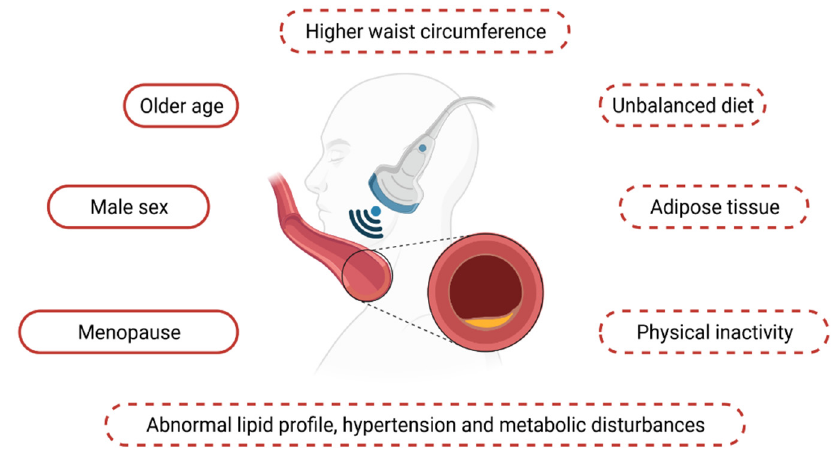
Figure 2. Factors associated with the increased cIMT values. Factors with dashed lines are modifiable and can be changed by behavioural or pharmacological actions.